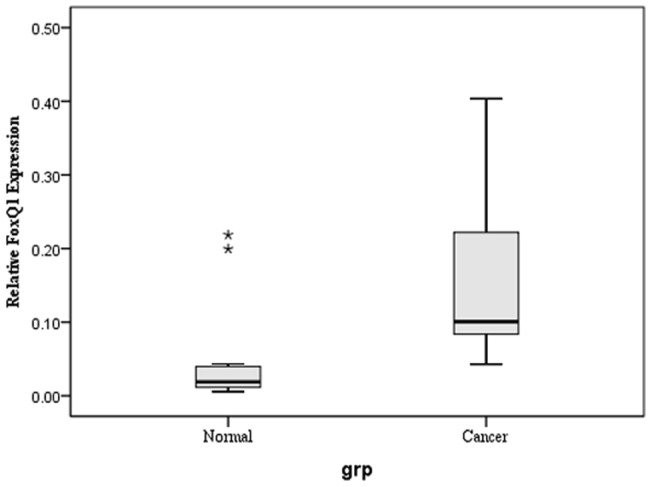
Expression of FoxQ1 mRNA in NSCLC tissues and corresponding non-cancerous tissues.One-step q RT-PCR was performed to confirm the expression of FoxQ1 mRNA in human tissues. Results were normalized to GAPDH mRNA level. The FoxQ1 mRNA level in NSCLC tissues were higher than that in peritumoural tissues with statistical significance using a paired-samples T test. **
P<0.05. Bars indicate standard error (S.E.).